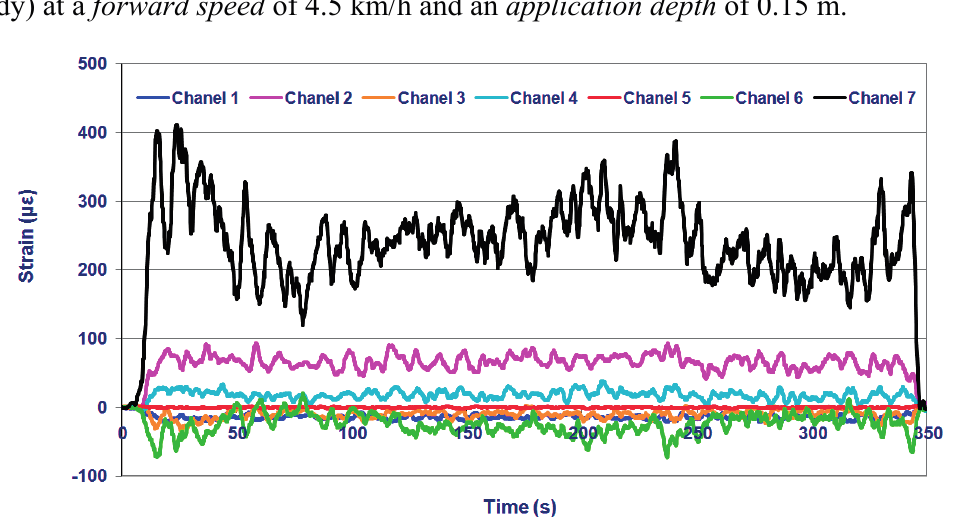
Figure 6. Strains ( με ) recorded in the experimental test in field 2 (sandy) at a forward speed of 4.5 km/h and an application depth of 0.15 m. Rosette: Channels 1–3; 3 Linear strain gauges: Channels 4, 6, and 7; Reference strain gauge: Channel